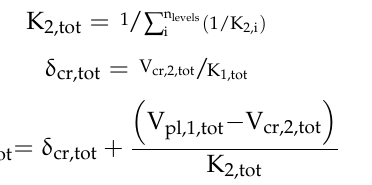
Table 4. Summary table of the relationships defining the proposed analytical curves.